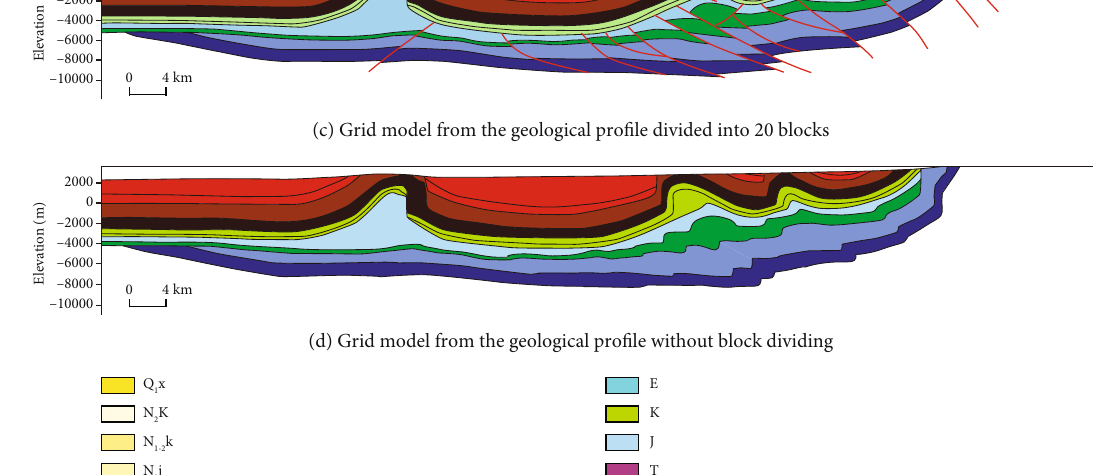
Figure 4: Geological section through the Keshen-2 well and the geological model with